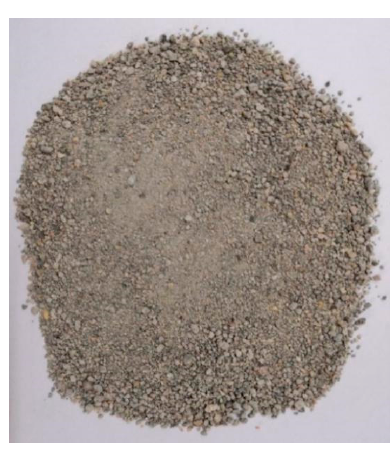
Figure 3. The appearance of the produced CRFA.